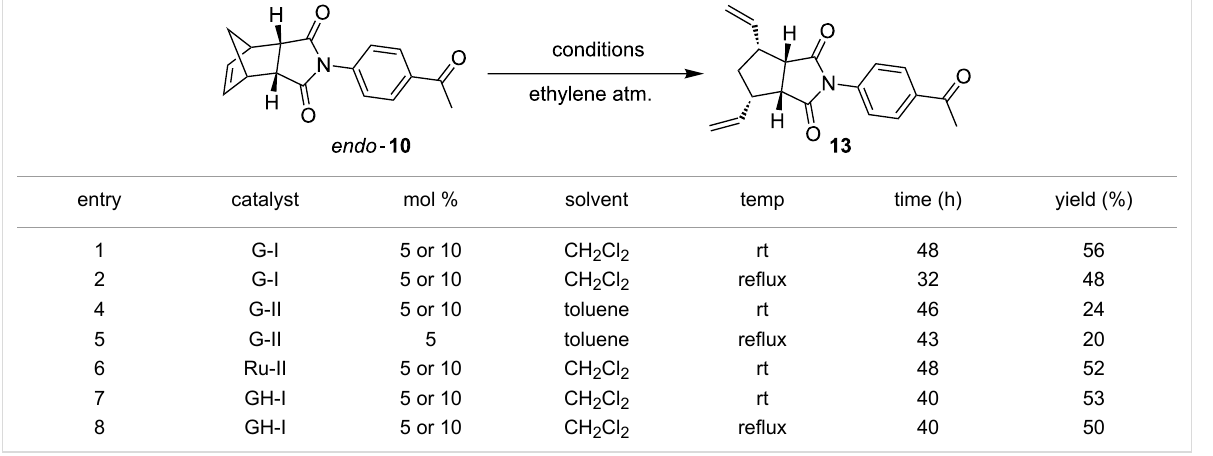
Table 1: Different conditions attempted to obtain the ROM product 13